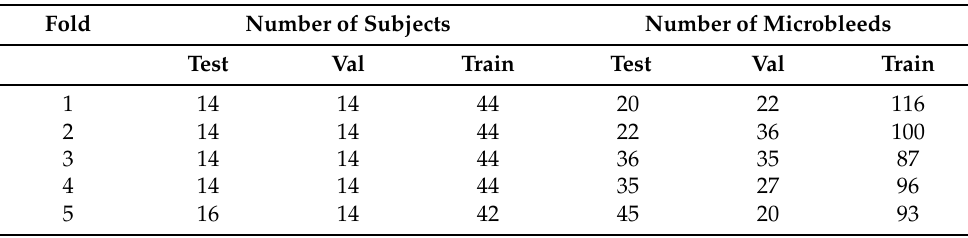
Table 2. Folds used in model evaluation.